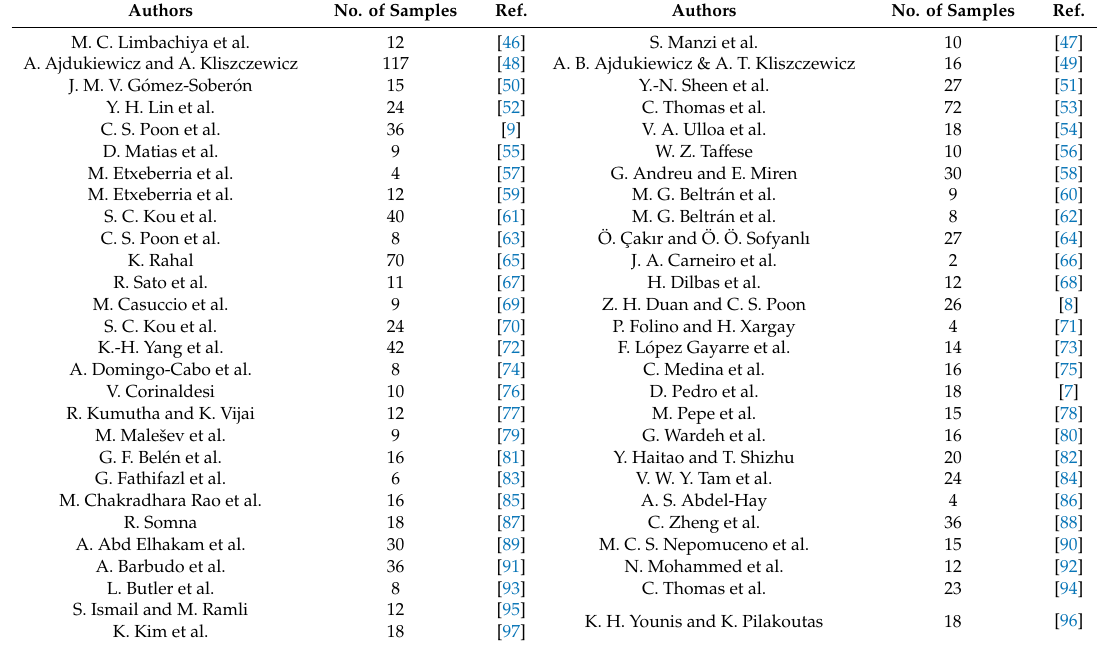
Table 2. Sources of experimental data used in this